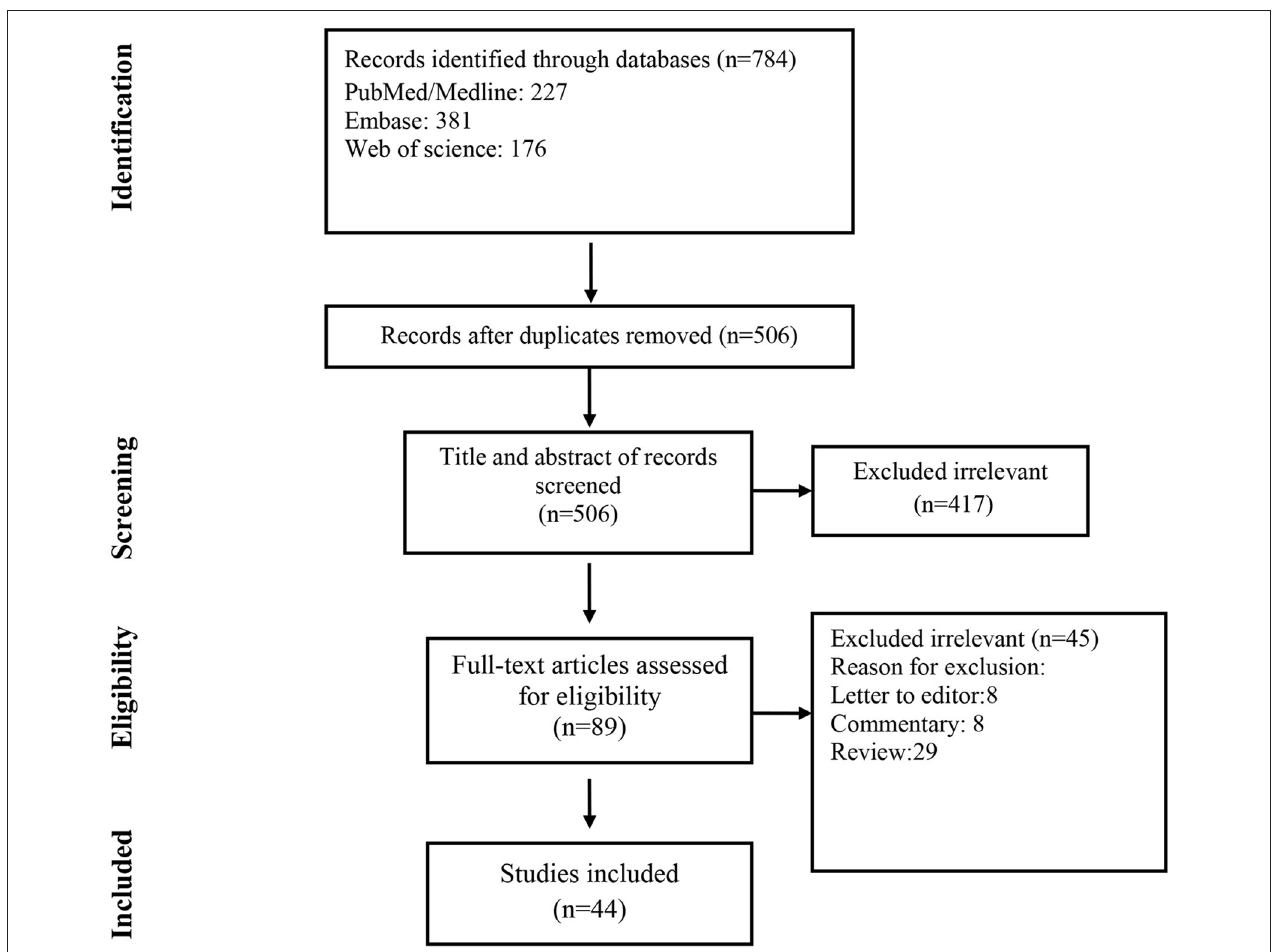
FIGURE 1 | Flow chart of study selection for inclusion in the systematic